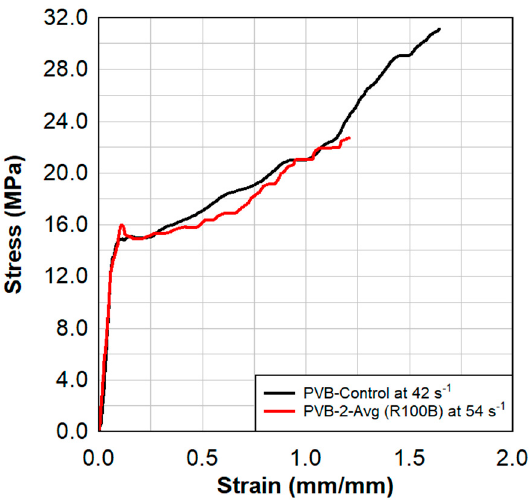
Figure 9. Dynamic tensile test results of the average of the three radiated PVB − 2 specimens in comparison to the virgin PVB.